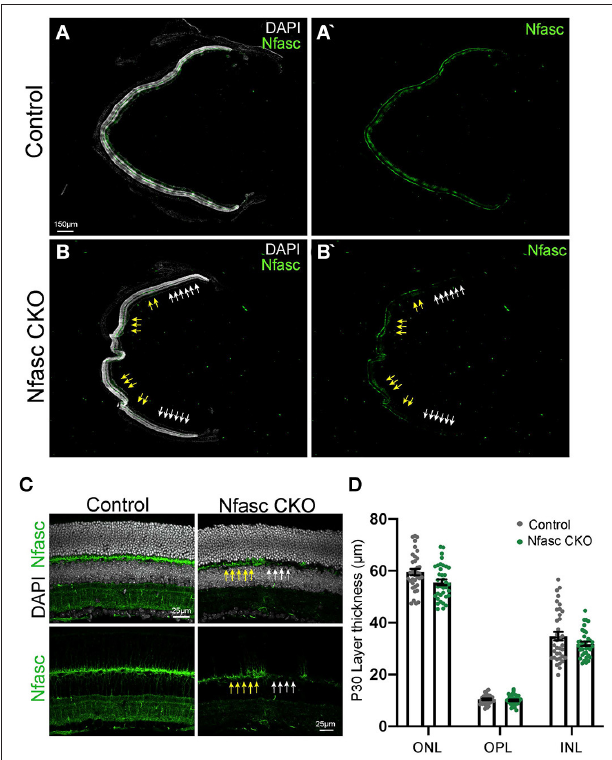
FIGURE 2 | Incomplete loss of Nfasc protein expression in Nfasc CKO (A–D) . Representative retinal sections of controls (A,A’) and Nfasc CKO (B,B’) taken with a 10X objective and the tiling confocal scanning feature. Nfasc protein expression (anti-Nfasc, green) is absent in a mosaic columnar manner (white arrows) throughout the retina in Nfasc CKO where there are remaining areas with Nfasc expression (yellow arrows). Nuclei is stained with DAPI. Higher magnification of retinal sections is shown in (C) . Measurements of retinal layer thickness represented as mean values in controls ( n = 36 retinal sections from four different animals) in black and Nfasc CKO ( n = 36 retinal sections from four animals) in green at P30 (D) . Scale bar shown in (A,C) .